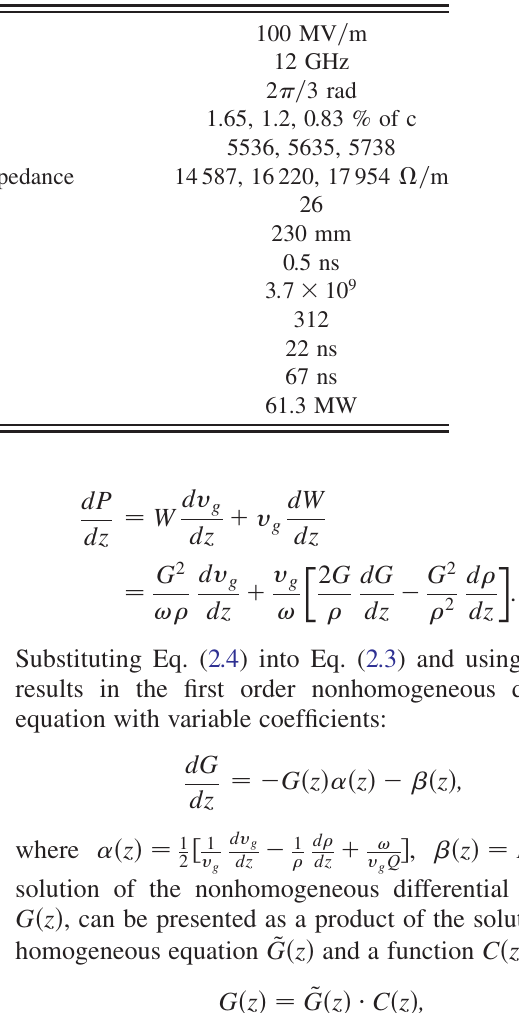
TABLE I. Parameters of the CLIC main linac accelerating structure.